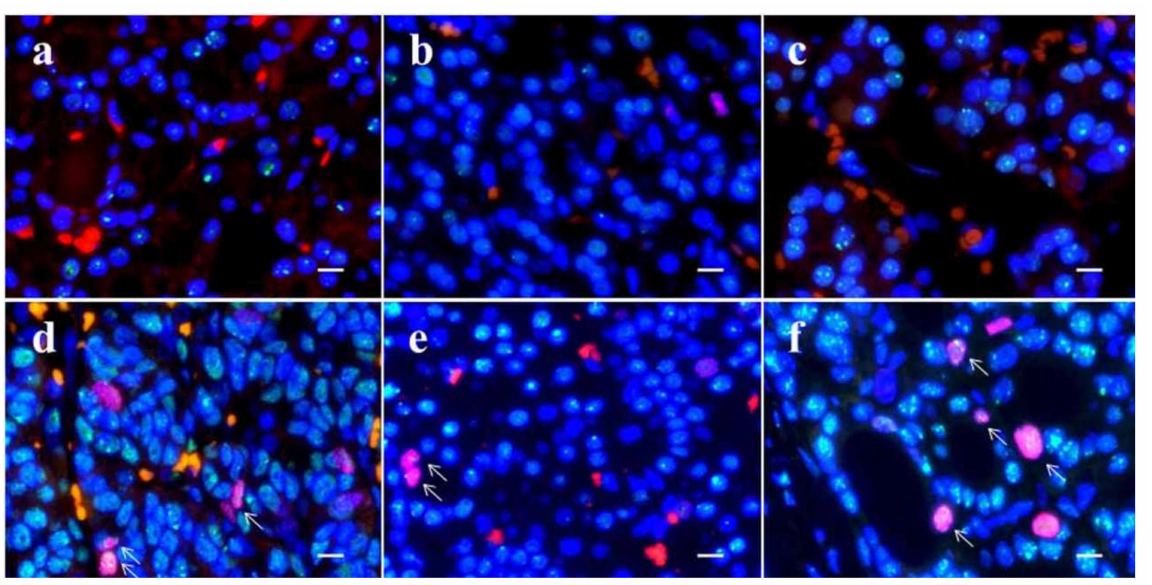
Figure 6. Dual-color immunofluorescence for TP53-binding protein 1 (53BP1) (green) and Ki-67 (red) in thyroid follicular-patterned tumors. Adenomatous goiter ( a ); follicular adenoma ( b ); outer nodule in nodule-in-nodule (NN) appearance tumor with poorly differentiated component (PDc) ( c ); PDc in NN ( d ); minimally invasive follicular carcinoma ( e ); and widely invasive follicular carcinoma ( f ). Arrows in ( d , e , f ) indicate double-positive types. The scale bars indicate 10 µ m.